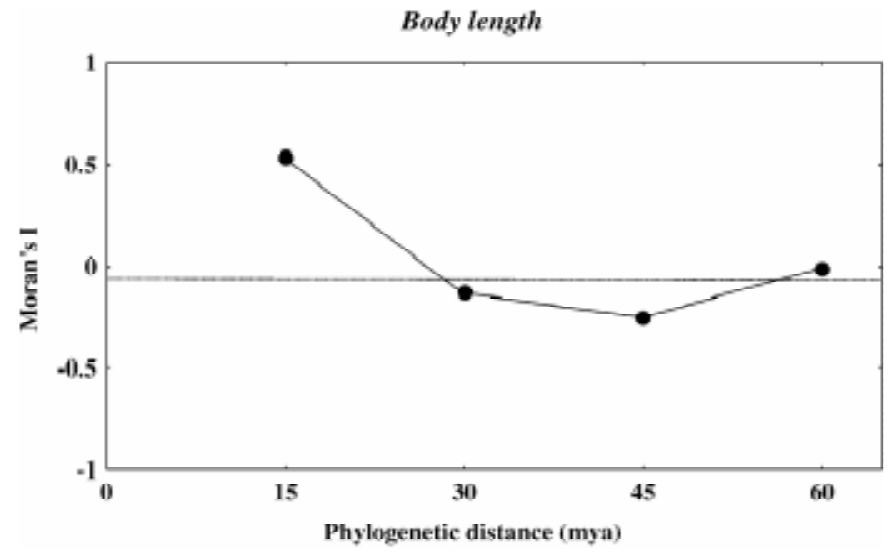
Figure 2 - Phylogenetic correlogram with four Moran’s I coefficients for body size in 19 species of South American owls. Dashed line indicates the expected value under the null hypothesis of no